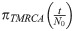
Probability density functions, πTMRCA(tN0), for different scenarios of populations size change, constant (upper plot) and exponentially growing with ρ = 1 (middle plot) and ρ = 10 (lower plot).Probability distributions are shown for different genealogy sizes n = 10, n = 100 and n = ∞ (limit distribution).